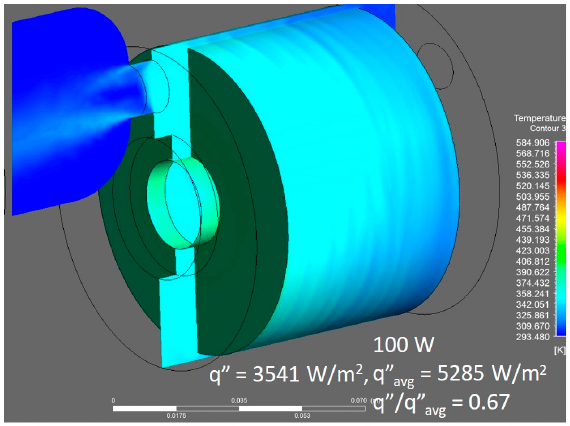
Figure 21. Isotherms for rotor parasitic heat flux q ” = 3541 W/m 2 .